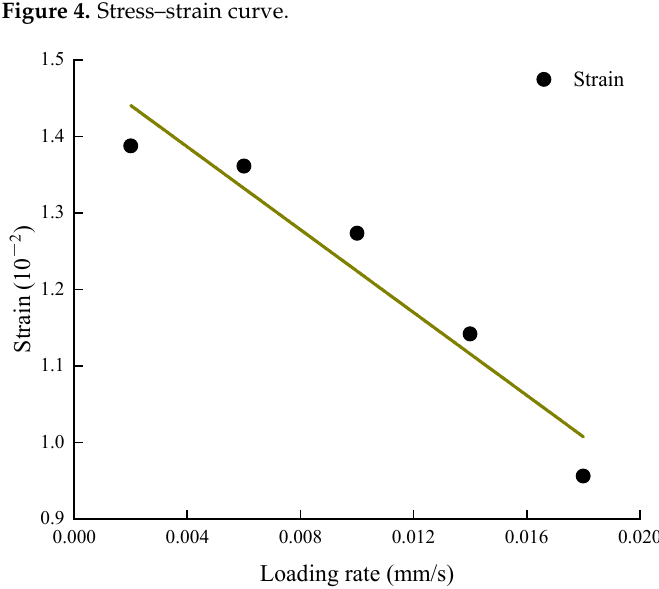
Figure 5. Variation Trend of corresponding strain value at stress peak.